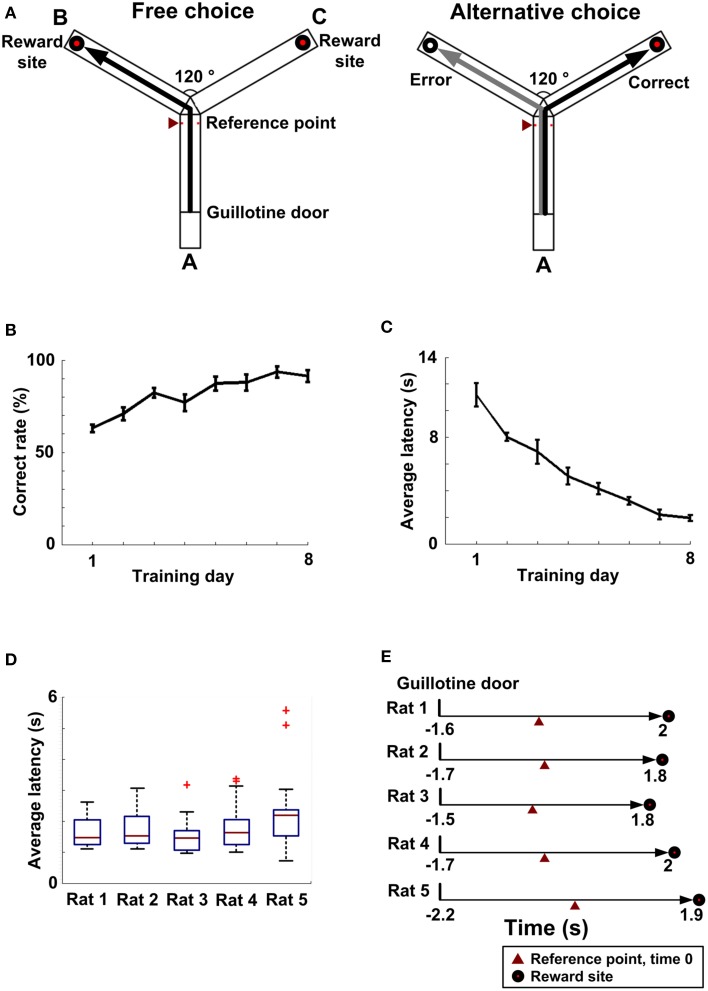
Working memory behavior. (A) A working memory task on a Y-maze (overhead view). An entire trial contained a free choice run (left) and an alternative choice run (right). Left: Arm A is a start arm. Reward sites are located at the ends of two goal arm B and C. RT was recorded by an infrared detector (red triangle). Right: A black line represents a correct choice and a gray line represents an error choice. (B) As training processed, the average rate of correct choice gradually increased (n = 5 rats). (C) As training continued, the average latency (n = 5 rats) gradually decreased. (D) The latency distribution (from the guillotine door to the choice point, nRat1 = 24 trials, nRat2 = 15 trials, nRat3 = 21 trials, nRat4 = 32 trials, nRat5 = 22 trials) for each rat. (E) Average latency (from the guillotine door to the reward site, nRat1 = 24 trials, nRat2 = 15 trials, nRat 3 = 21 trials, nRat4 = 32 trials, nRat 5 = 22 trials) over entire trials for each rat.